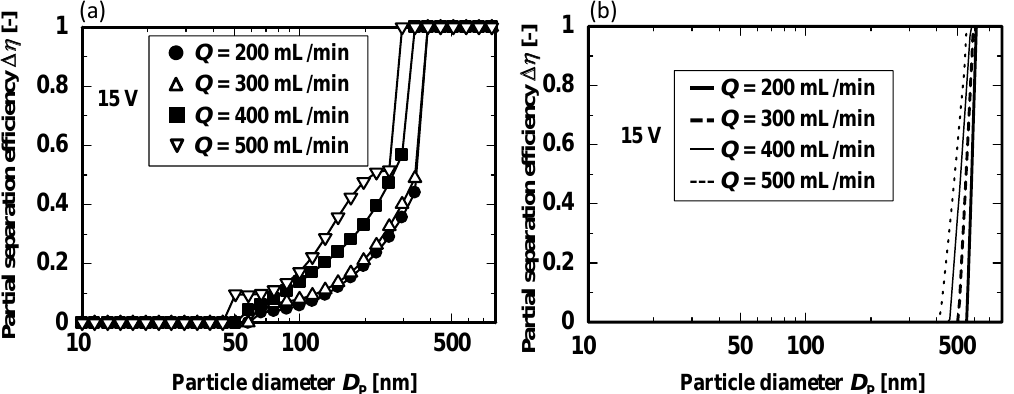
Fig. 8 Effect of flow rate on partial separation efficiency curves at the applied voltage of 15 V by: (a) experiment; (b) numerical simulation according to